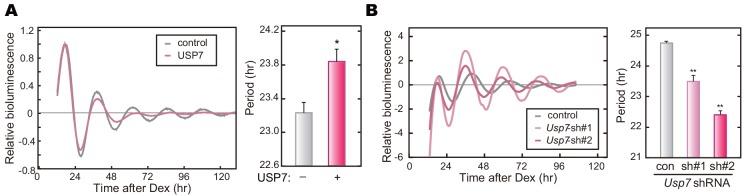
Usp7 knockdown shortens the circadian period of the cellular rhythms.A. NIH3T3 cells were transfected with a luciferase reporter vector, Bmal1 us0.3-luc, and USP7 expression vector. Twenty-four hours after the transfection, the cellular rhythms were synchronized by 30-min treatment with 0.1 μM dexamethasone (Dex). The culture medium was changed to the recording medium, and bioluminescence signals were recorded continuously. The calculated circadian periods are shown as means + SEM (n = 4, *: p < 0.05 by Student’s t-test). B. Cellular rhythms in Usp7 knockdown cells. Bioluminescence rhythms of Bmal1-luc reporter were recorded as described in A. The calculated circadian periods are shown as means + SEM (n = 4, **: p < 0.01 by Tukey’s test).